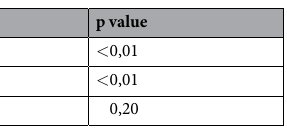
Table 3. Post-test group by group analyzing BW and weight reached in adult